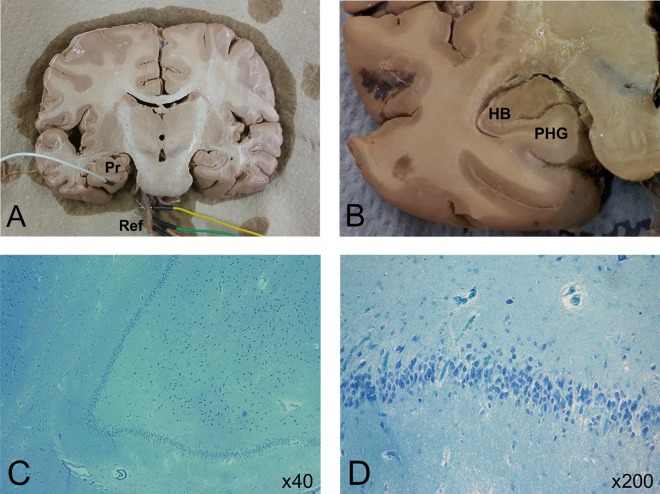
Coronal sections of human brain tissue fixed in EFA.Each section was equipped with a needle electrode inserted into the grey matter of the left parahippocampal gyrus (Pr) referenced (Ref) to the basilar artery (A). The hippocampal body (HB) and parahippocampal gyrus (PHG) served as the regions of interest (B). Cytoarchitecture of the hippocampal body fixed in EFA can be visualized under x40 (C) and x200 (D) magnification in stained (Toluidine Blue-O) sections.